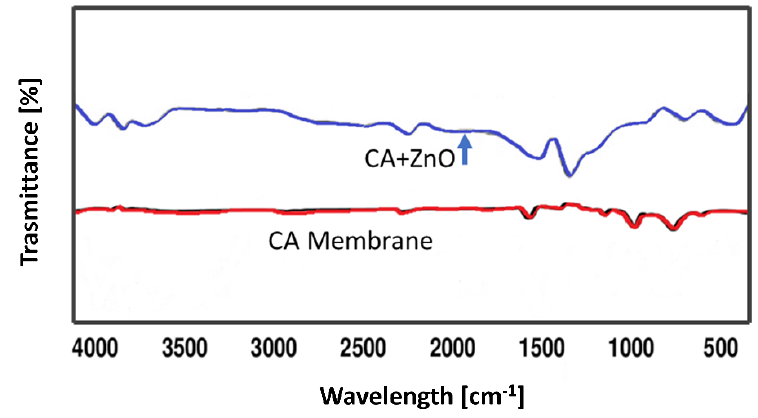
Figure 4. FTIR spectra of CA and CA-ZnO blended membrane.